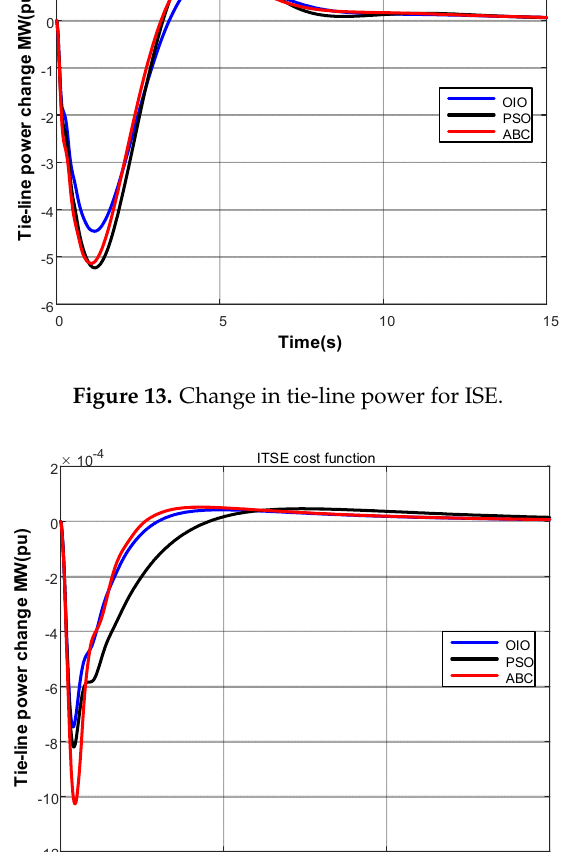
Figure 14. Change in tie ‐ line power for ITSE.